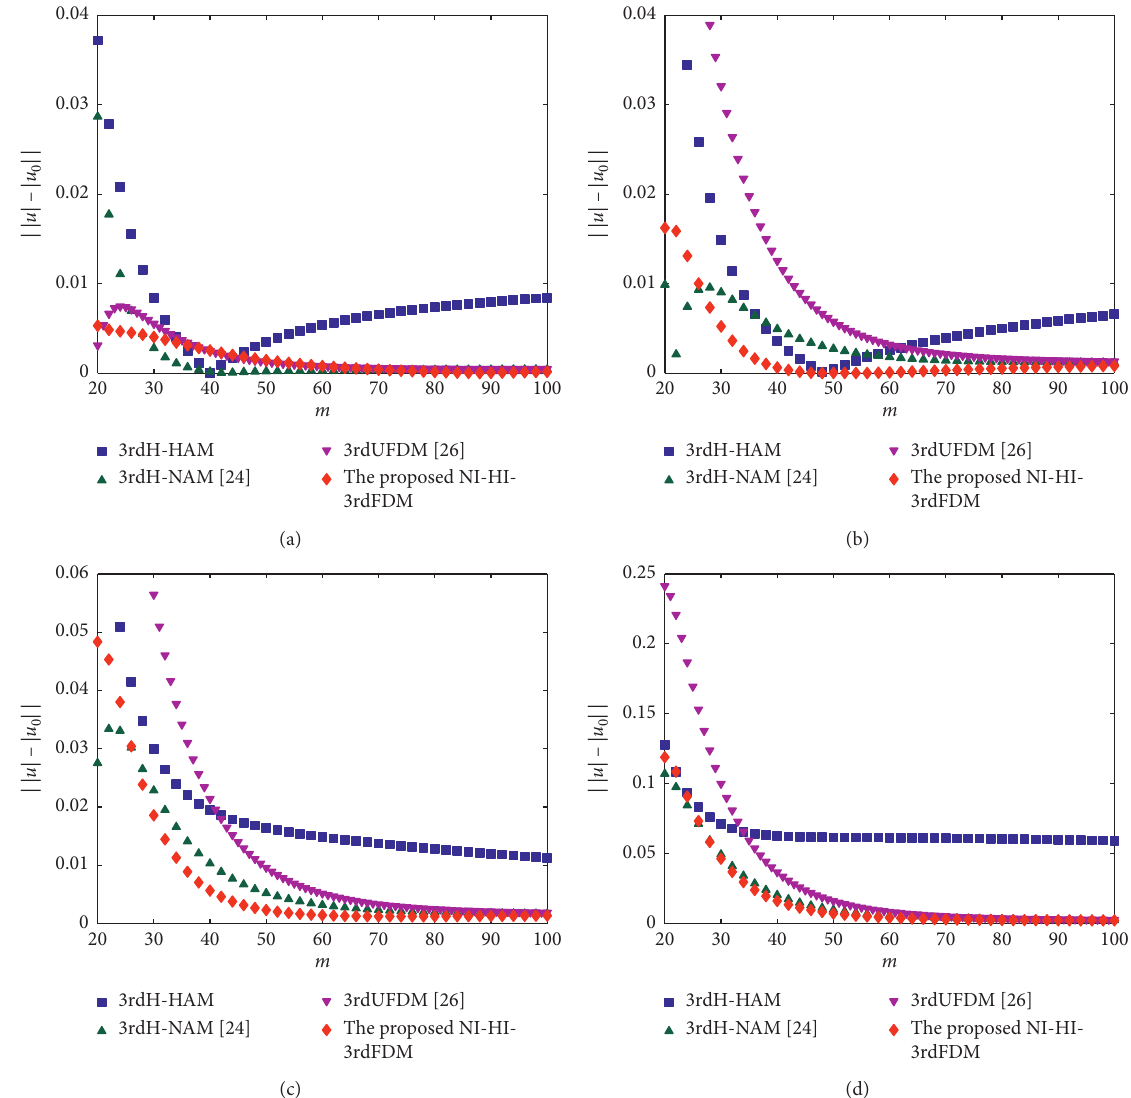
Figure 2: Comparison of convergence rates between the proposed NI-HI-3rdFDM and existing methods. (a) w � 0.2mm, | u | � 1 . 0726; (c) w � 0.7mm, | u w � 0.5mm, | u 0